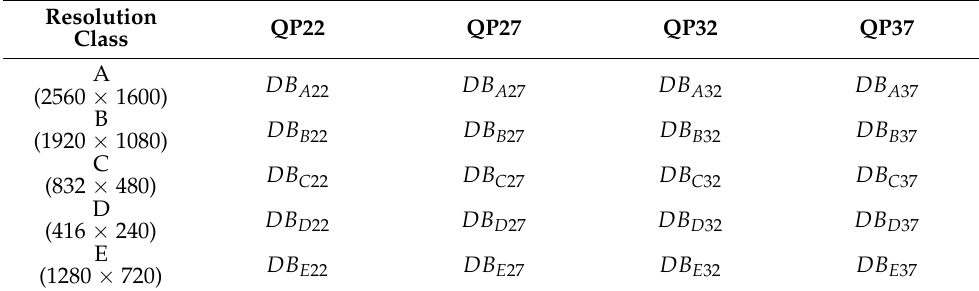
Table 3. Databases for bagged tree models of each QP and resolution